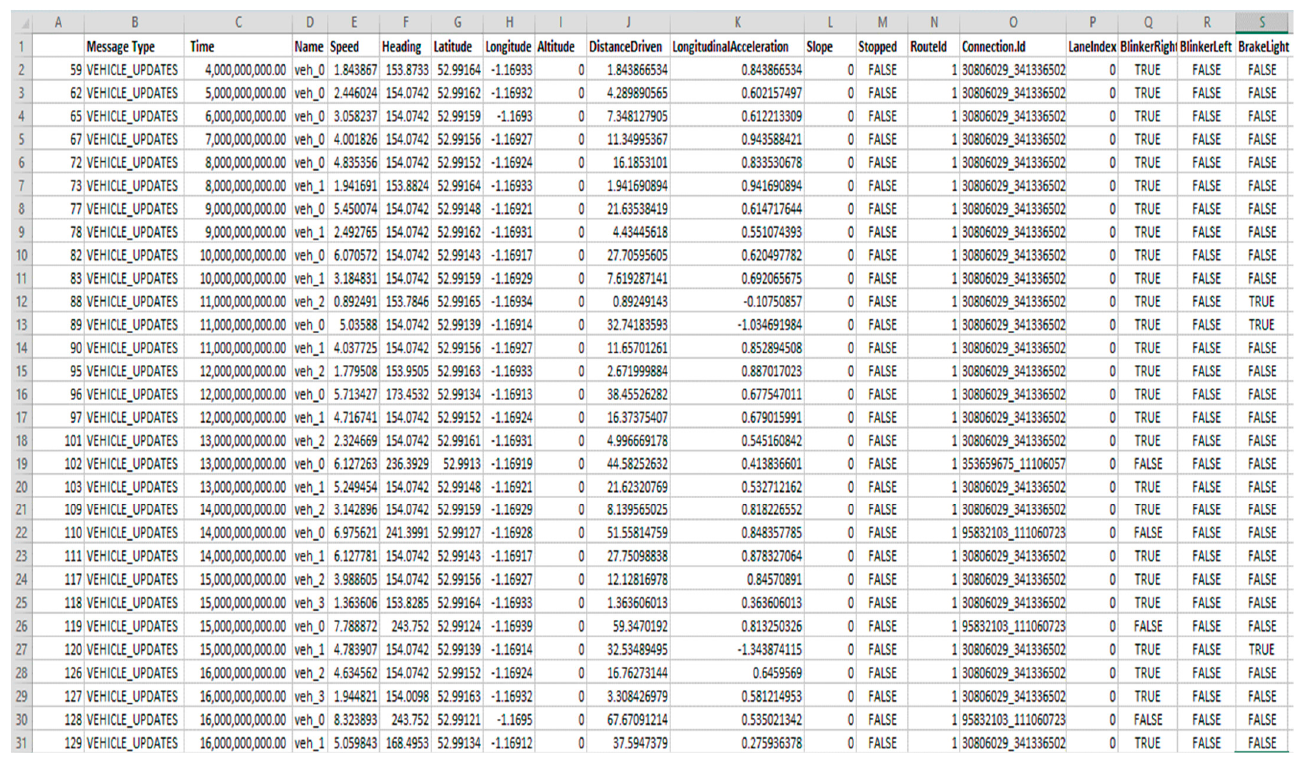
Figure 13. Samples from the vehicle updates dataset.